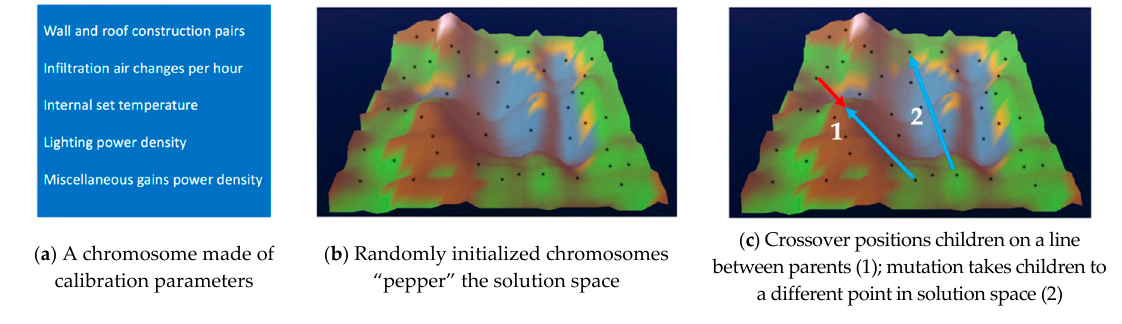
Figure 3. Initialization and processing of the first generation of chromosomes.